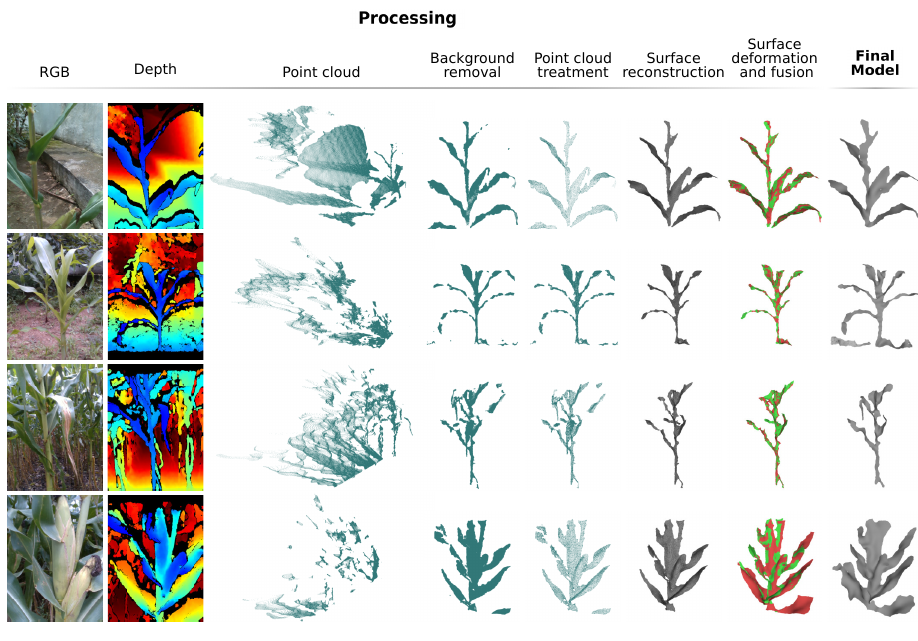
Figure 16. Examples of models generated by the proposed system.